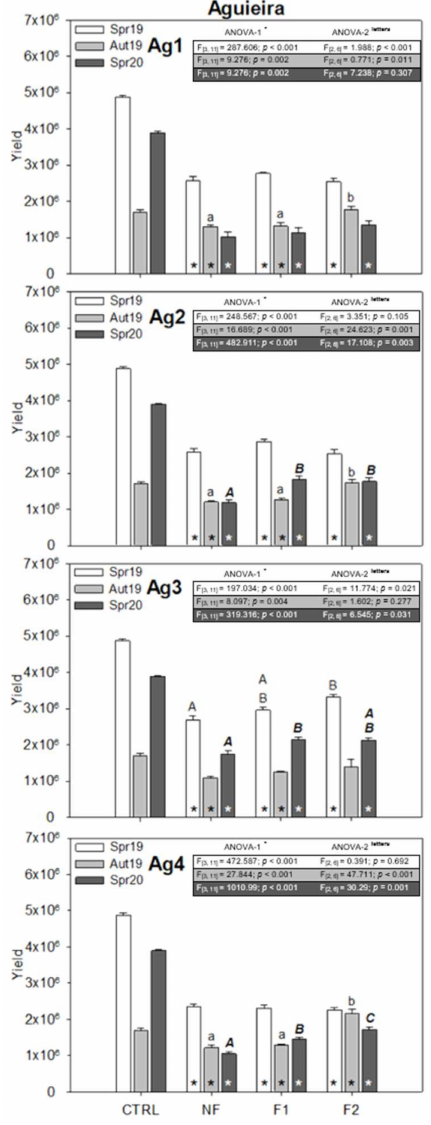
Figure 4. Results of Yield of R. subcapitata from the Aguieira reservoir, when exposed to treatments: control (CTRL) and natural water treatments (NF—Non-filtered water; F1 and F2—filtered with 1.2 µ m and 0.22 µ m, respectively). Data are stated as mean ± standard error (SE); n = 3. * Stands for significant differences detected by Dunnett test. Different letters (A, B for Spr19; a, b for Aut19 and A , B , C for Spr20) stands for significant differences between treatments, detected by Tukey